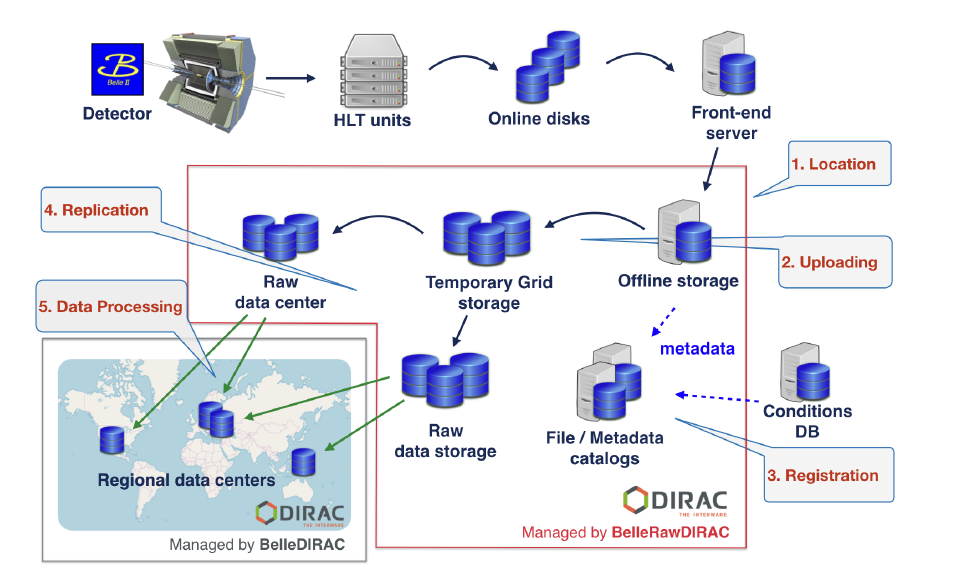
Figure 2. Belle II raw data flow through online - o ffl ine - grid. Raw data files recorded by the detector are transferred from the online system to o ffl ine servers. BelleRawDIRAC takes the raw data files from an o ffl ine server and performs the registration and replication. With the files located on the two raw data centers, reprocessing of the raw data files is performed on the